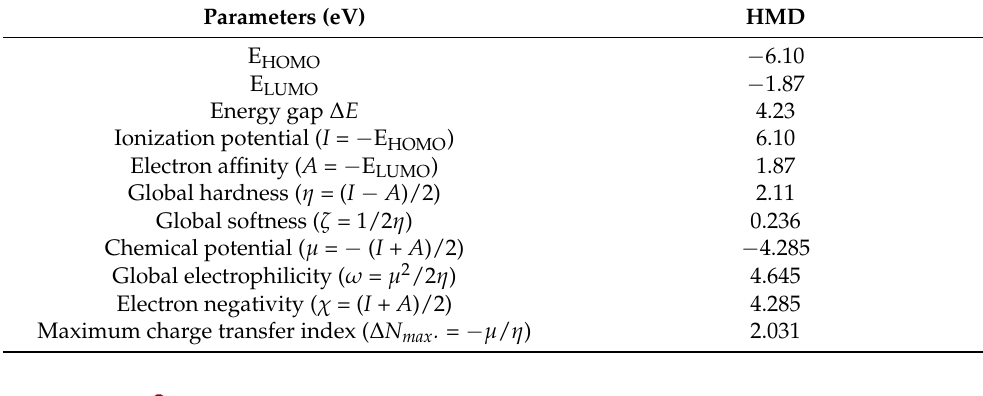
Table 5. Global descriptor values for HMD.